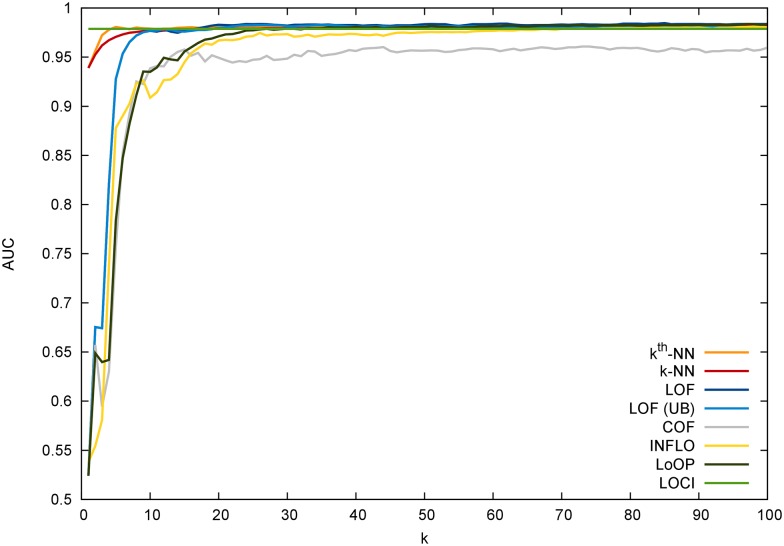
The AUC values for the nearest-neighbor based algorithms on the breast-cancer dataset.It can be seen that k values smaller than 10 tend to result in poor estimates, especially when considering local anomaly detection algorithms. Please note that the AUC axis is cut off at 0.5.